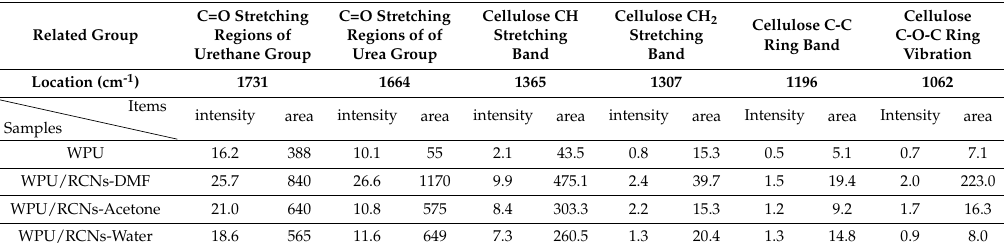
Table 2. Curve-fitting results of WPU and RCNs/WPU nanocomposites FTIR spectra.